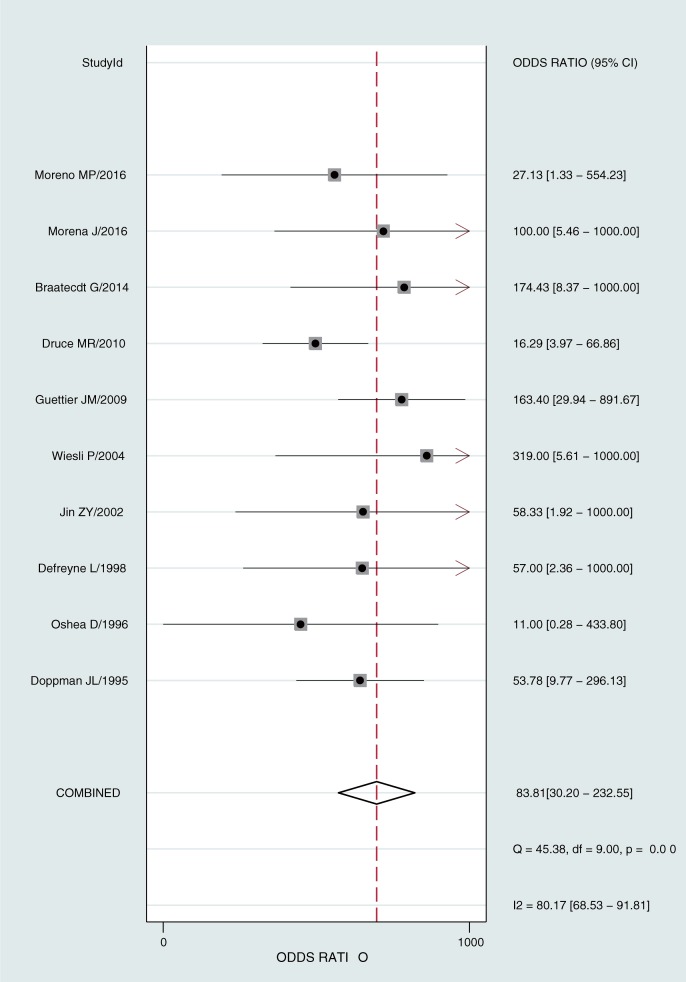
Forest plot for DOR.